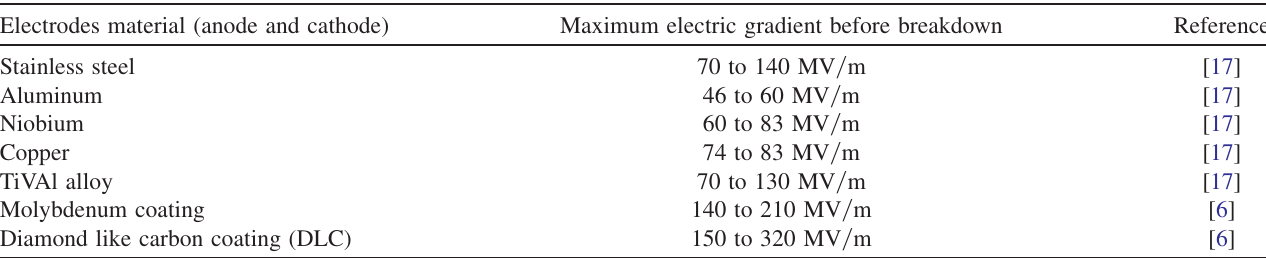
TABLE I. Range of maximum electric field sustained by different electrodes in the diode (without conditioning and without laser illumination) for gaps ranging between 1.5 and 6